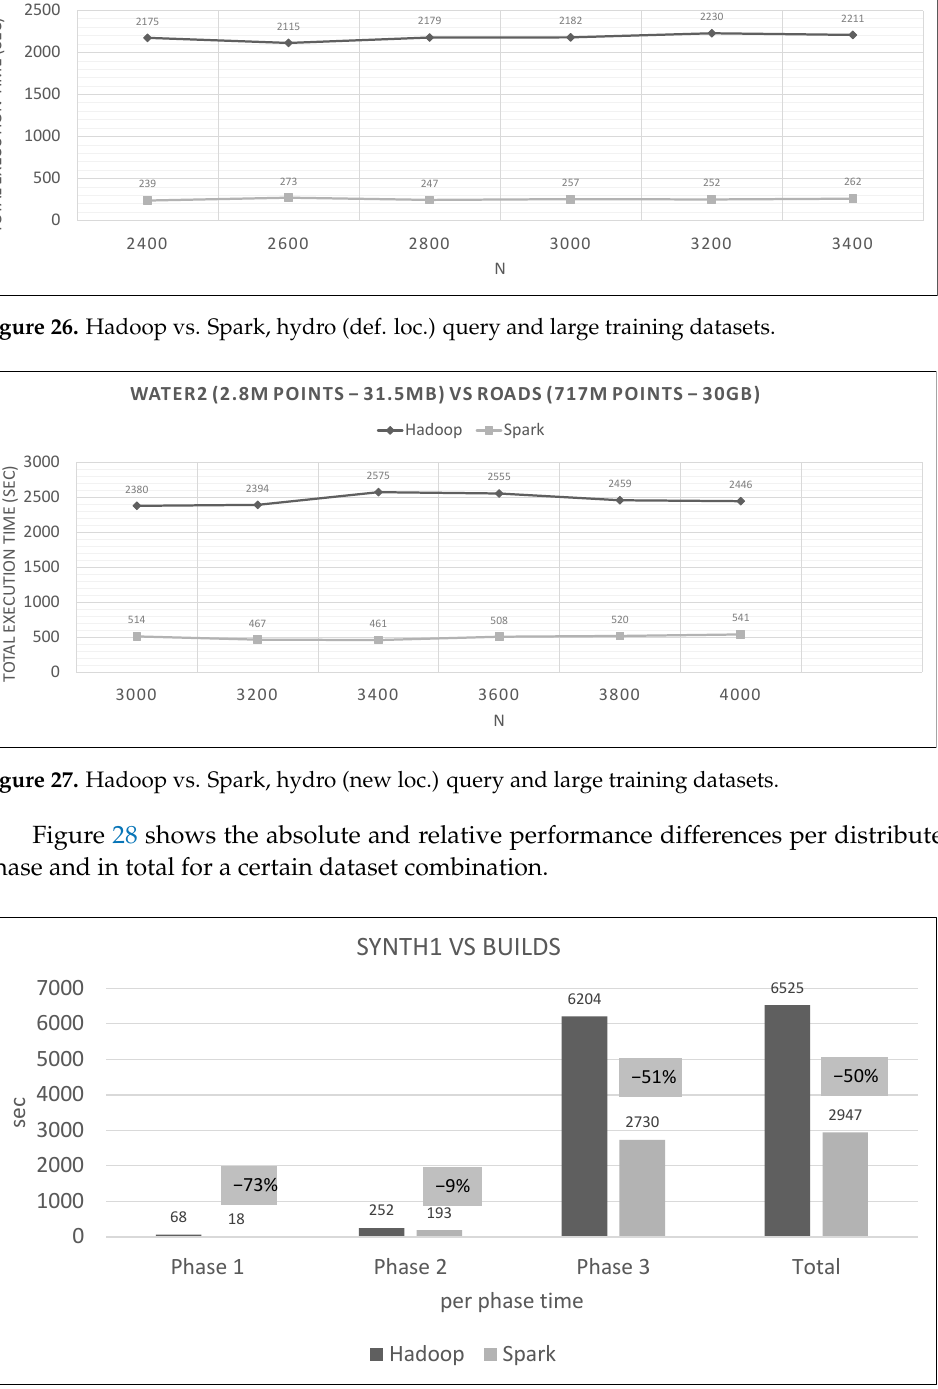
Figure 28. Hadoop vs. Spark, per phase performance ( N =